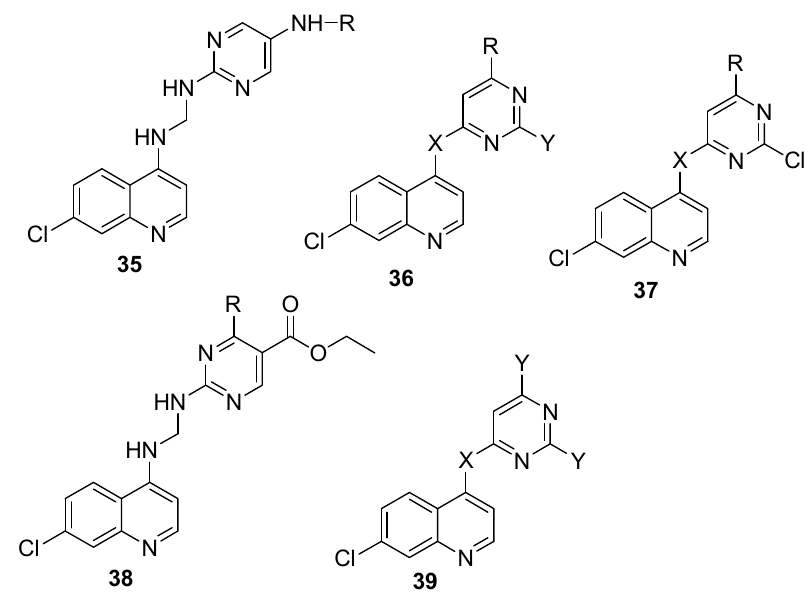
Figure 7. Quinoline-pyrimidine hybrid compounds.